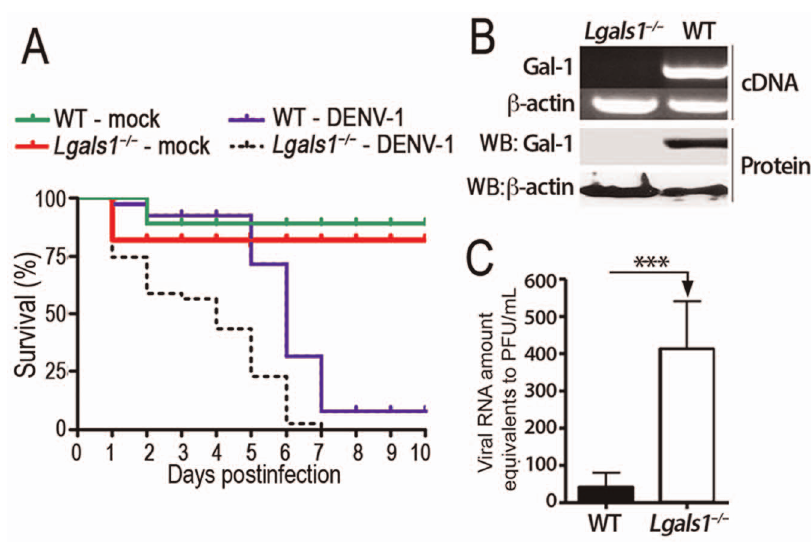
Figure 5. Gal-1 is physiologically relevant to in vivo infection with DENV-1. (A) Newborn WT and Lgals1 –/– mice were intracerebraly infected with 10 6 PFU/ml of DENV-1 mouse-brain adapted or mock (supernatant from mouse brain not infected with DENV-1) and their mortality was monitored for 10 days. Results are shown as the percentage survival from five independent assays performed with 6–8 mice per group. (B) Total mRNA isolated from resident peritoneal macrophages of Gal-1-deficient ( Lgals1 –/– ) and wild-type (WT) mice was converted into cDNA and the Gal-1 expression was analyzed using conventional PCR. The b -actin gene was used as an endogenous control. Alternatively, total protein from Lgals1 –/– and WT macrophages were isolated and Gal-1 expression was quantified by western blot assay and normalized to b -actin expression. (C) Peritoneal resident macrophages from Lgals1 –/– or WT mice were cultivated (5x10 5 /well) in 24-well plates and inoculated with DENV-1 at a MOI of 0.5. After 72 hours at 37 u C, cell-free supernatants were recovered and the viral loads were determined by Real-Time PCR. Results are showed as Viral RNA amounts equivalent to PFU/ml 6 SD from three experiments assessed in triplicates. ***p , 0.0001.